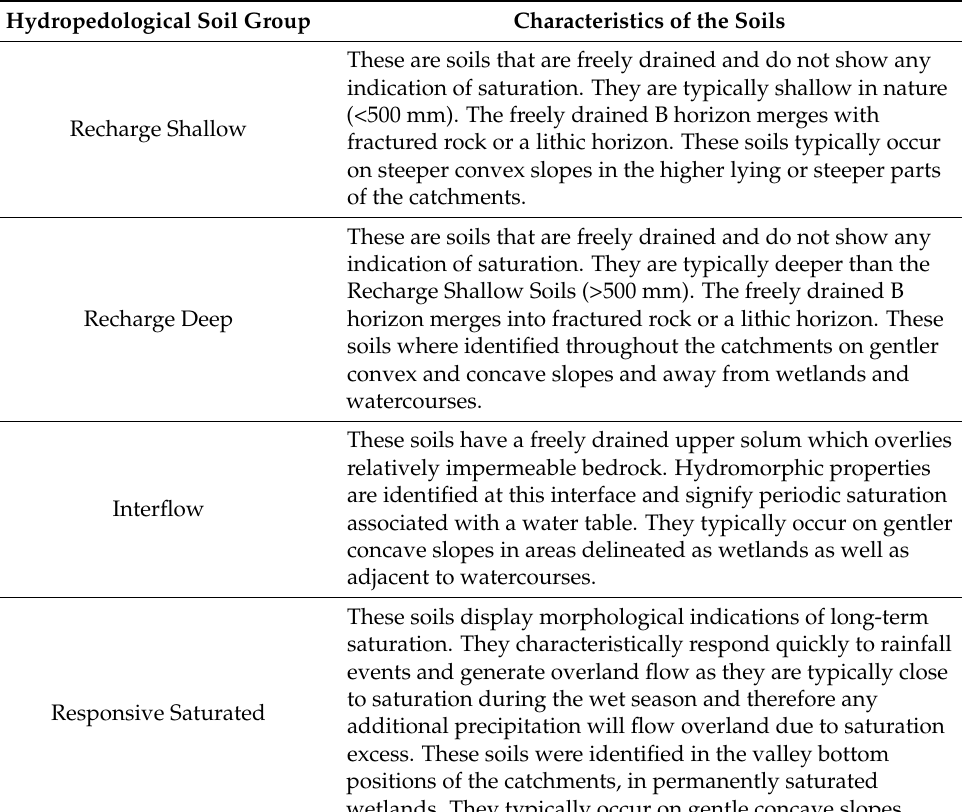
Table 2. Dominant properties of the dominant hydropedological soil groups